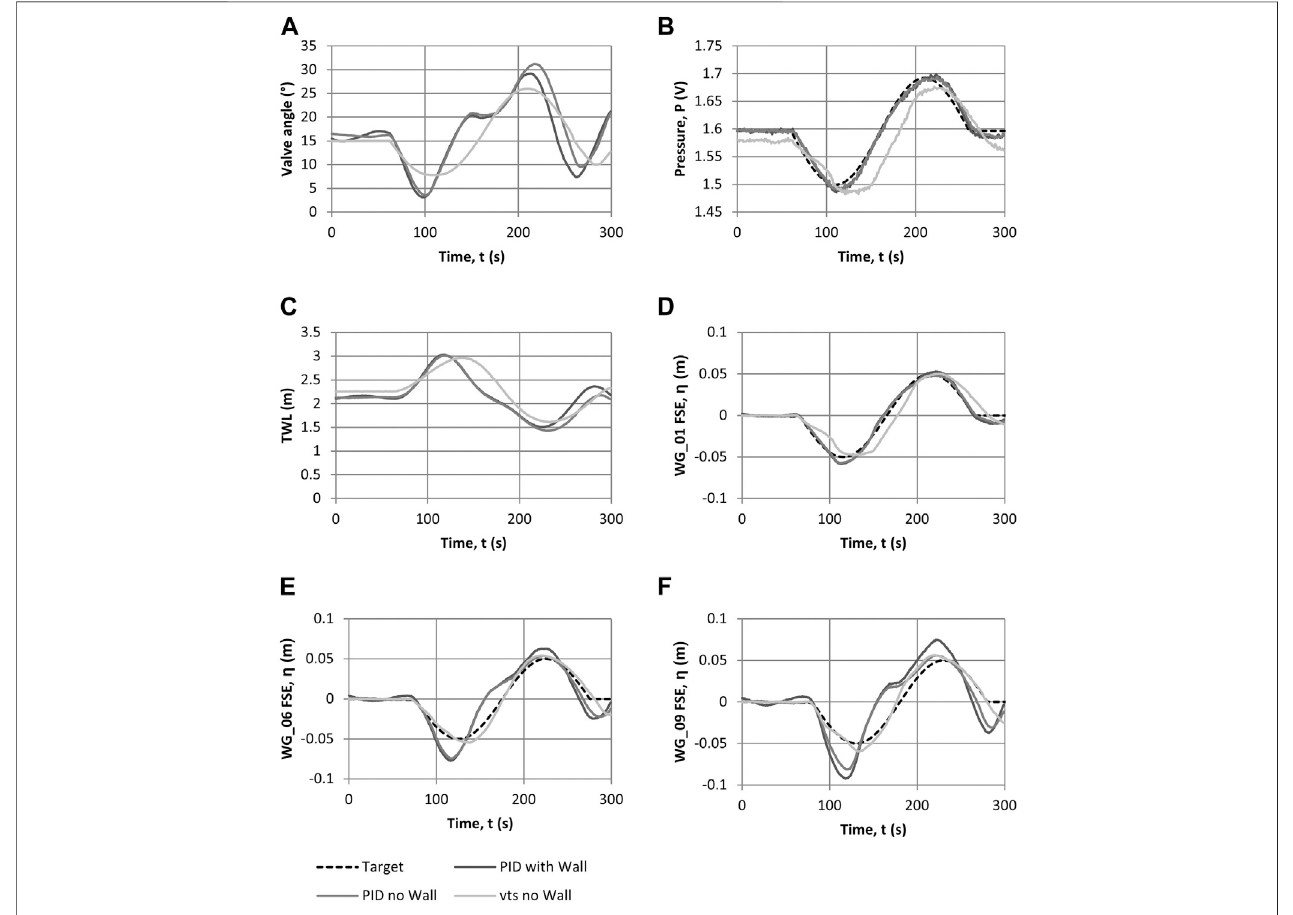
FIGURE 10 | Comparison of the three calibration runs (PID control with seawall, PID control without seawall and open-loop (valve time series, vts) control) of N200 wavefor (A) valveangle, (B) pressureatbaseofTS, (C) tankwaterlevel(TWL), (D) free-surfaceelevation(FSE)forWG_01(0.25 mfromTS,h (cid:2) 1.0 m),e)FSEforWG_06 (toe of the bathymetry, 27.47 m from TS, h (cid:2) 1.0 m) and f) FSE for WG_09 (closest to shore, 42.47 m from TS, h (cid:2) 0.25 m).